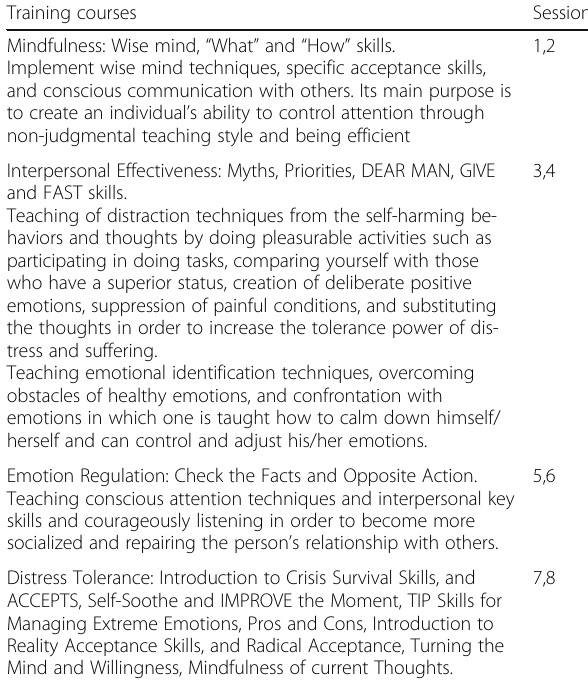
Table 2 The content of DBT training courses Training